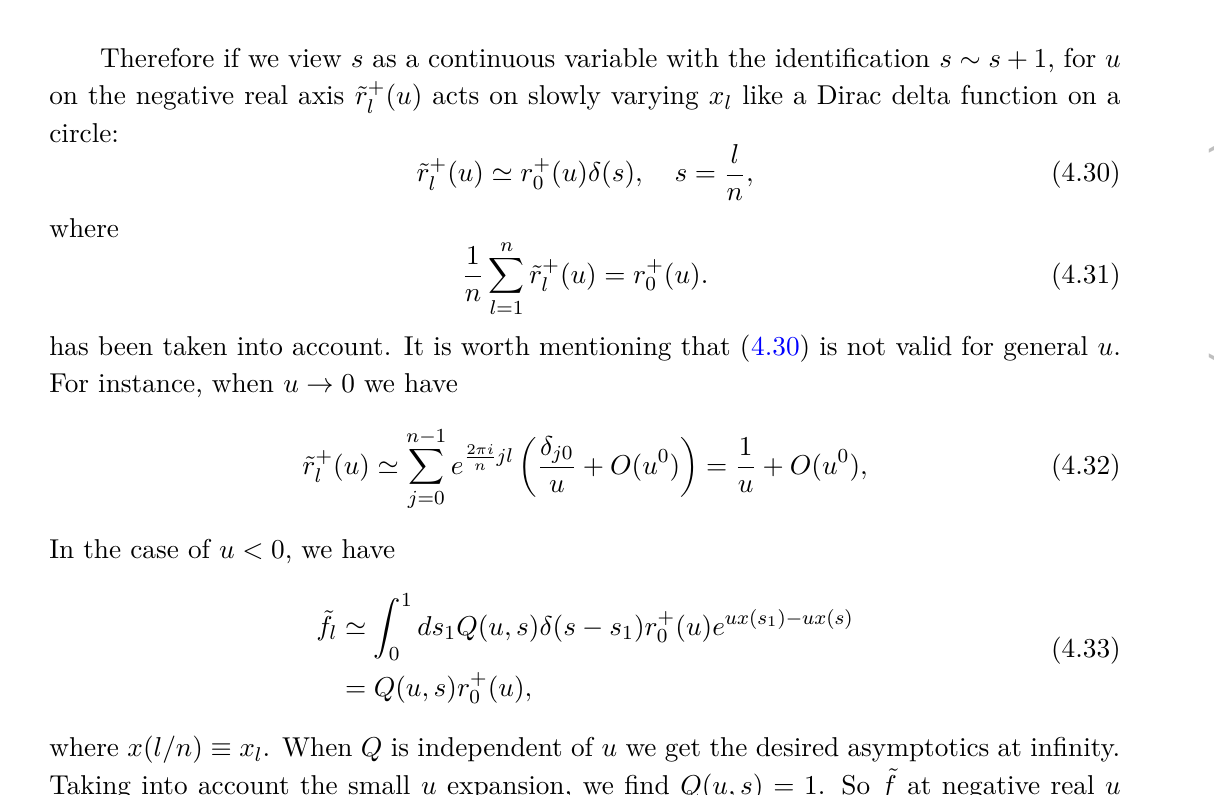
( − 2) with n = 1000 l